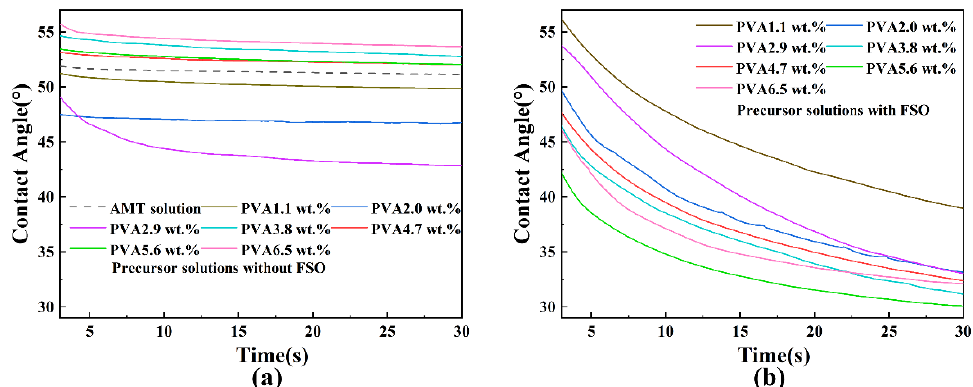
Figure 3. Ammonium meta-tungstate (AMT) solution and the precursor solutions: ( a ) relationship between contact angle and time without 2-perfluoroalkyl ethanol (FSO), ( b ) relationship between contact angle and time with FSO.